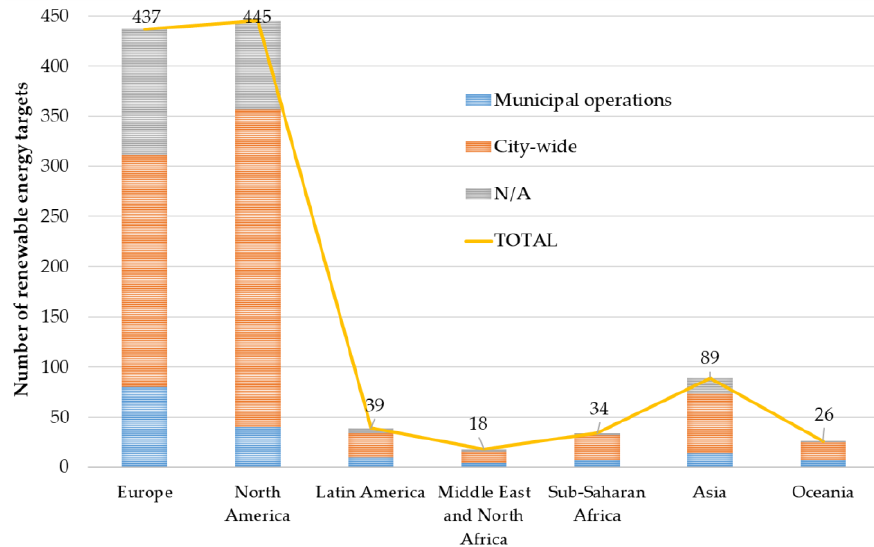
Figure 3. Number of renewable energy targets by the scale of application [50].